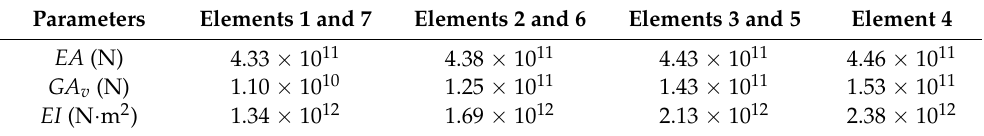
Figure 11. Yunbao Bridge: ( a ) cross-section and ( b ) finite element model (FEM). Table 3. Properties of the FEM of the bridge. Parameters